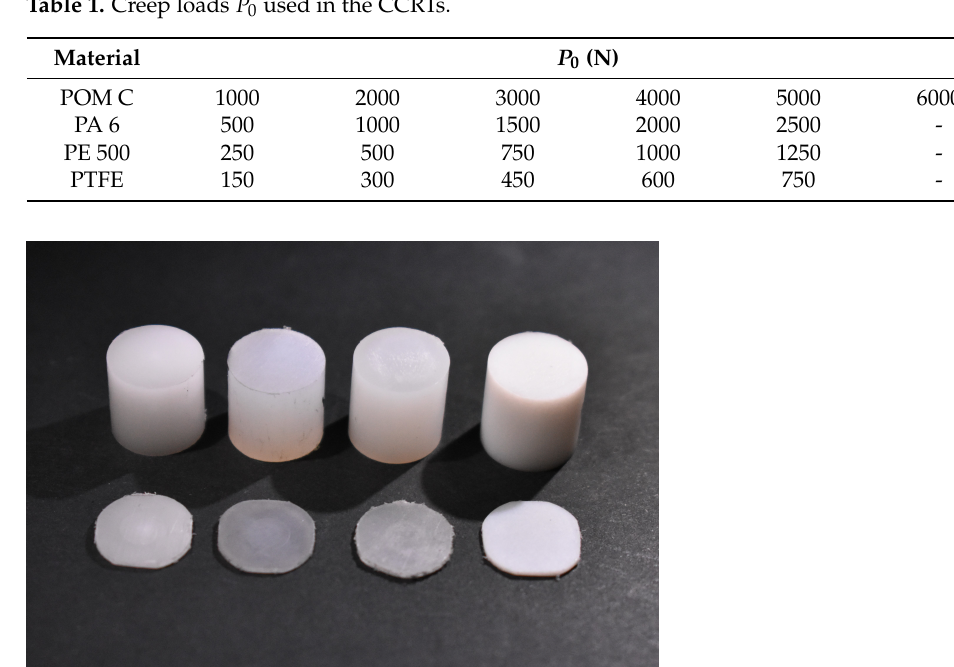
Figure 3. CCRT and SPCRT specimens, from left to right: POM C, PA 6, PE 500 and PTFE.